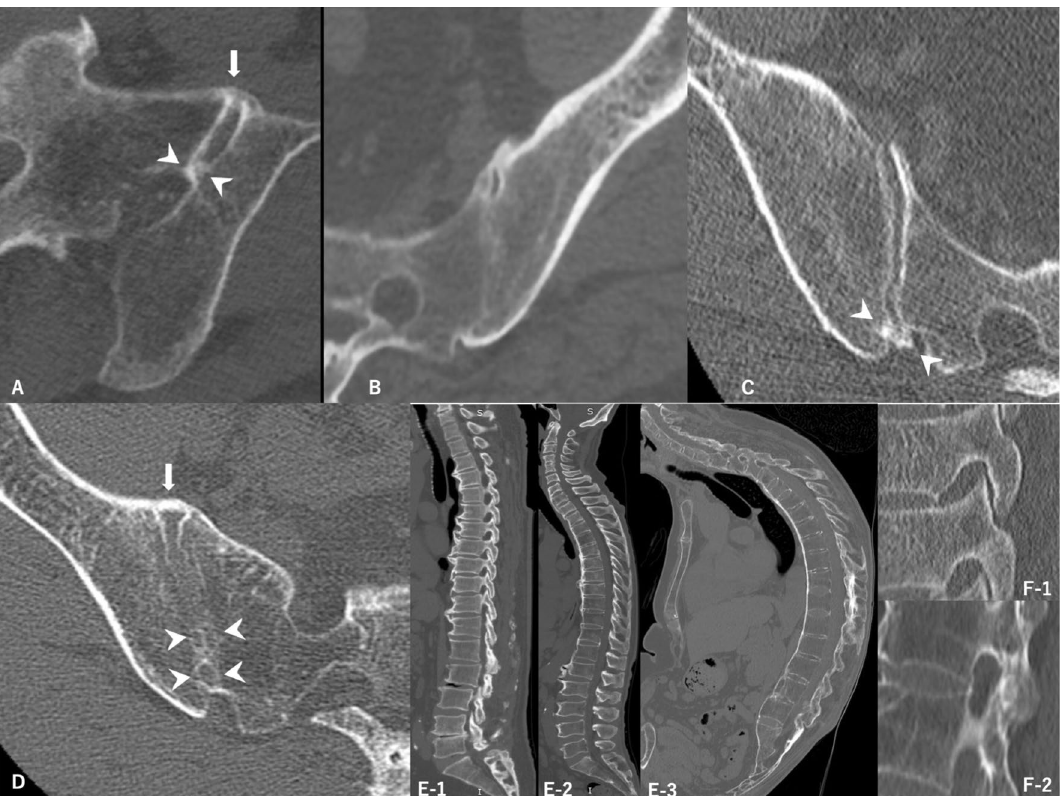
Figure 1. CT images of the spine and SIJ. ( A ) Axial CT image of SIJ shows anterior bony bridging (arrow) and partial fusion of joint (arrowhead). ( B ) Axial CT image of SIJ shows complete joint fusion. ( C ) Axial CT image of SIJ shows posterior bony bridging (arrowhead). ( D ) Axial CT image of SIJ shows anterior bony bridging (arrow) and entheseal bony bridging (arrowhead). ( E -1) Sagittal CT image of the whole spine shows 70–100% candle-wax-type. ( E -2) Sagittal CT image of the whole spine shows 30–70% candle-wax-type. ( E -3) Sagittal CT image of the whole spine shows 0–30% candle-wax-type. ( F -1) Sagittal CT image of the facet shows no fusion. ( F -2) Sagittal CT image of the facet shows